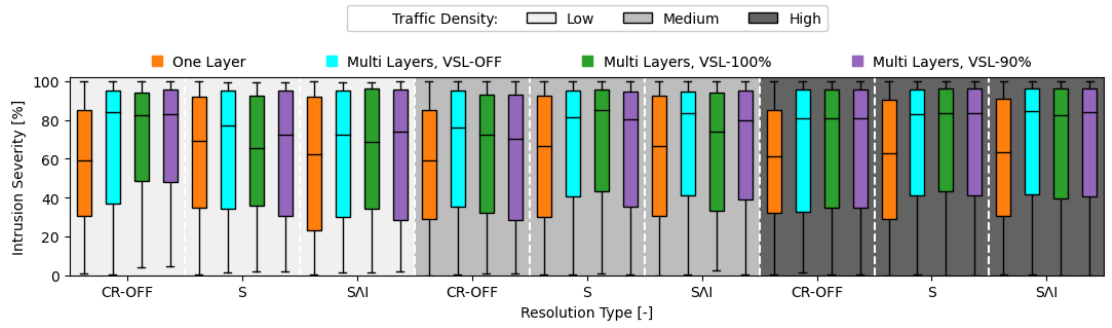
Figure 20. Intrusion severity rate.